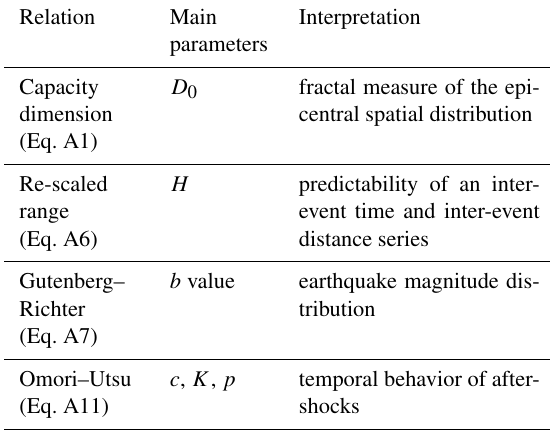
Table 1. Empirical relations, interpretation, and main